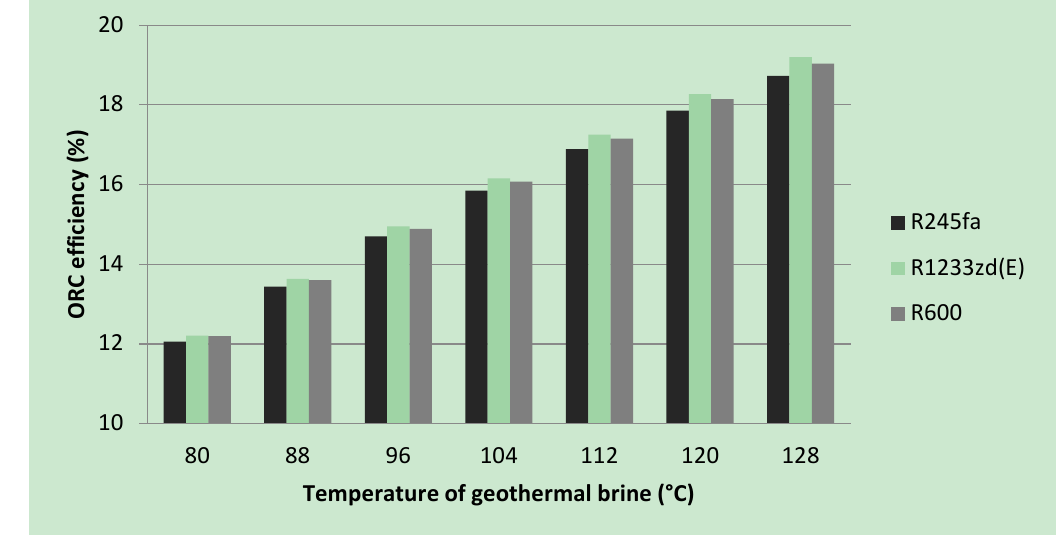
Figure 2. The efficiency of the ORC section in the modified system (assisted by gas turbine) as a function of the geothermal brine temperature.